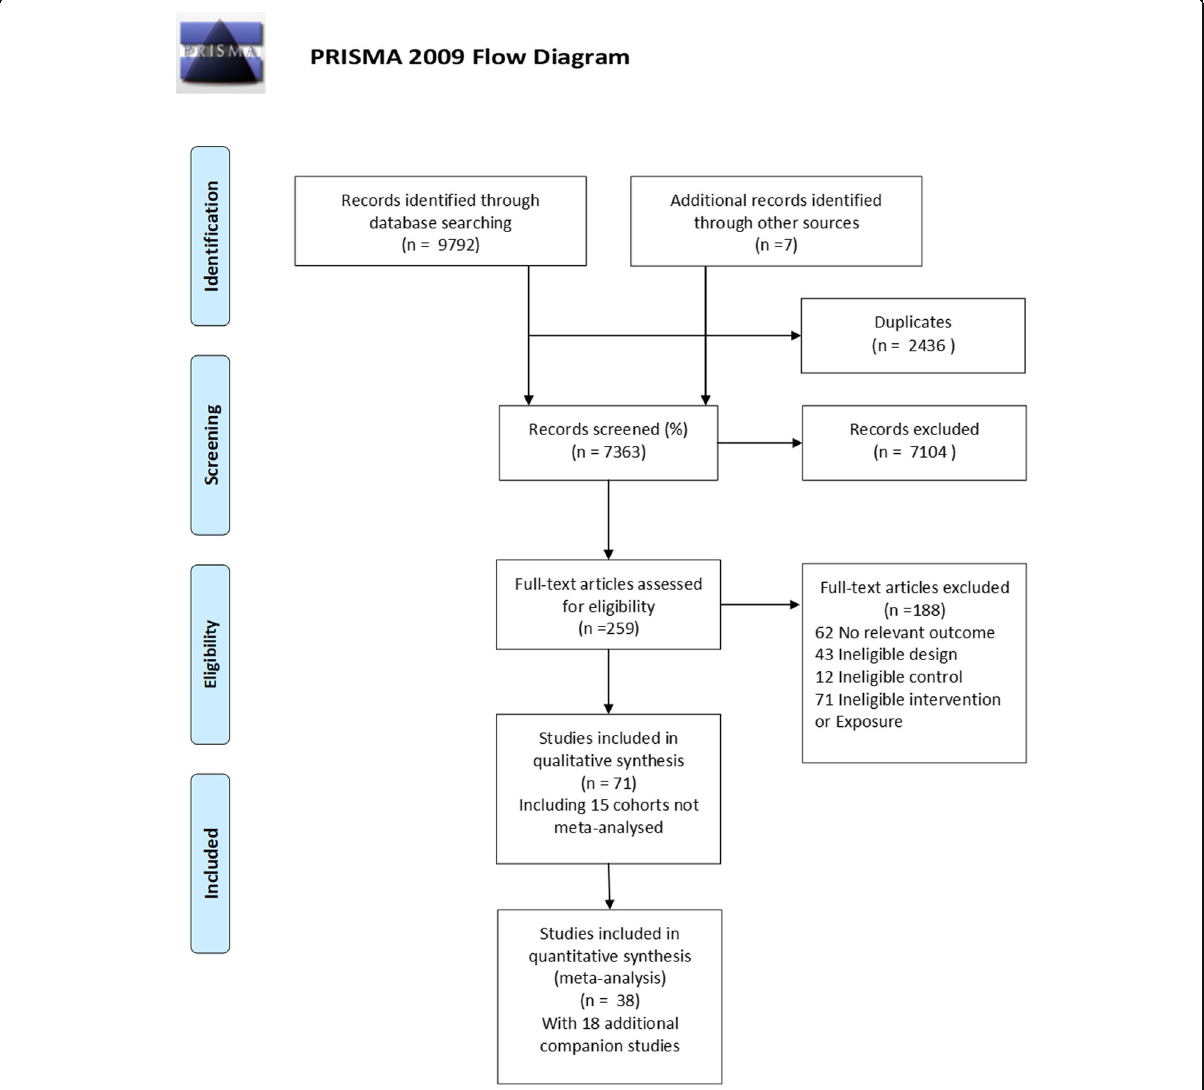
Fig. 1 Flow diagram of literature search and study selection according to the 2009 Preferred Reporting Items of Systematic Reviews and Meta-Analyses (PRISMA) with modifications [25]. *Companion articles represent reports involving the same study population for the same intervention trial,